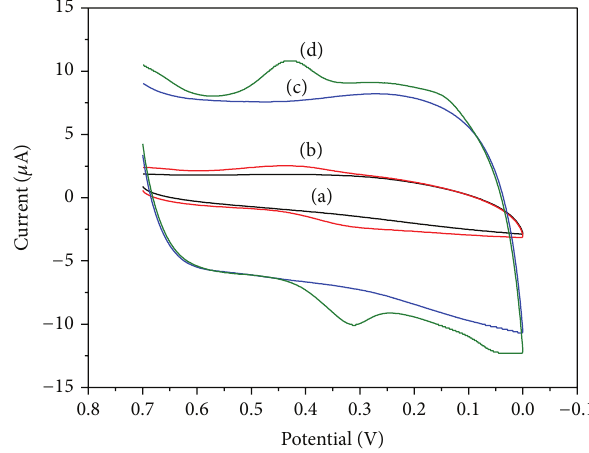
Figure 3: CVs of GCE (a, b) and PDDA-G/GCE (c, d) in acetate buffer solution (0.1mol L −1 , pH 3.0) with 5.86 × 10 −6 M FA (b, d) and without FA (a, c).